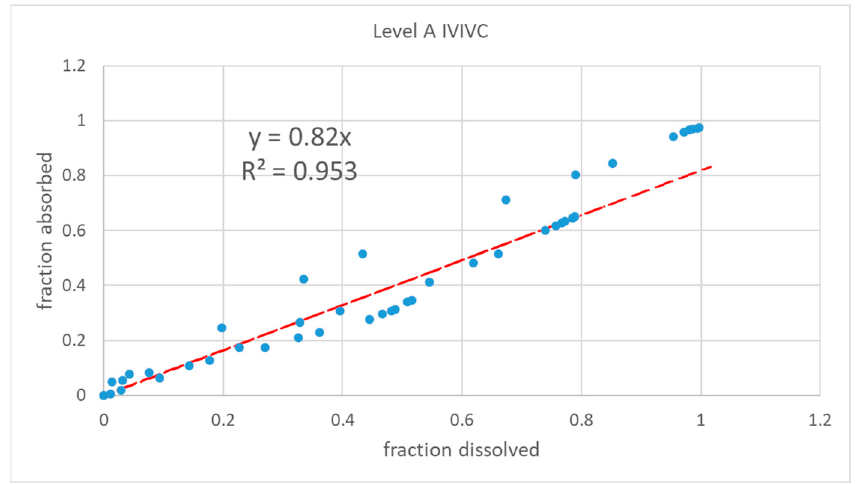
Figure 10. Levy plot constructed with Reference, Test 1, and Test 3 products.